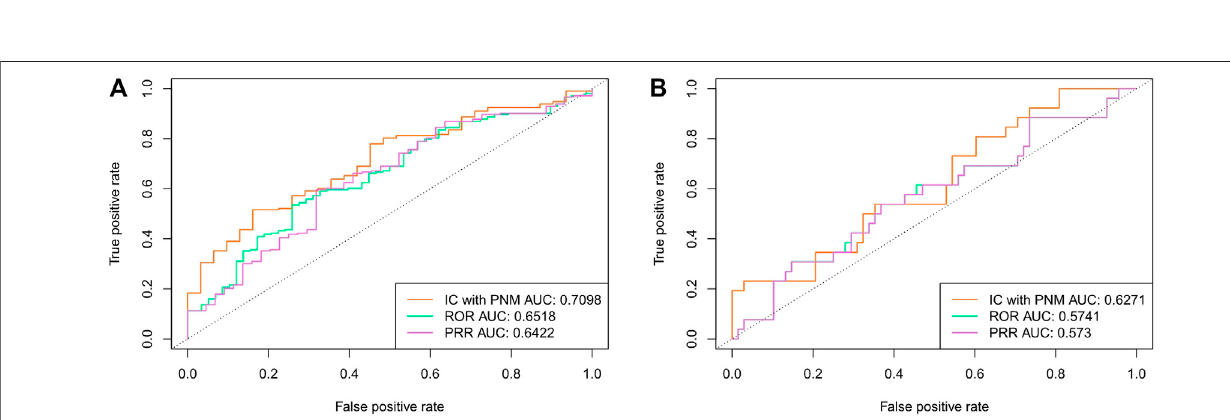
TABLE 2 | Results of performance of different signal detection algorithms using FAERS 2004 – 2009 data. Testing set